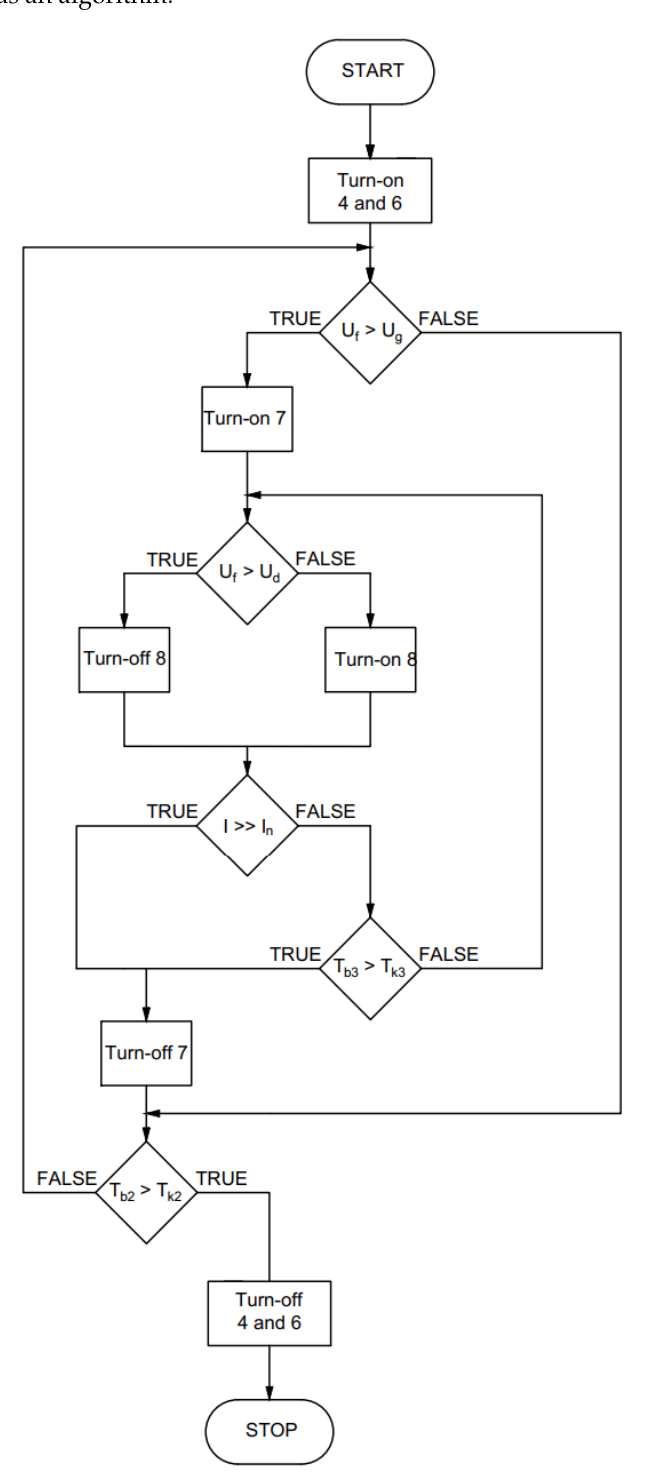
Figure 6. An algorithm of operating in the proposed novel SCB.